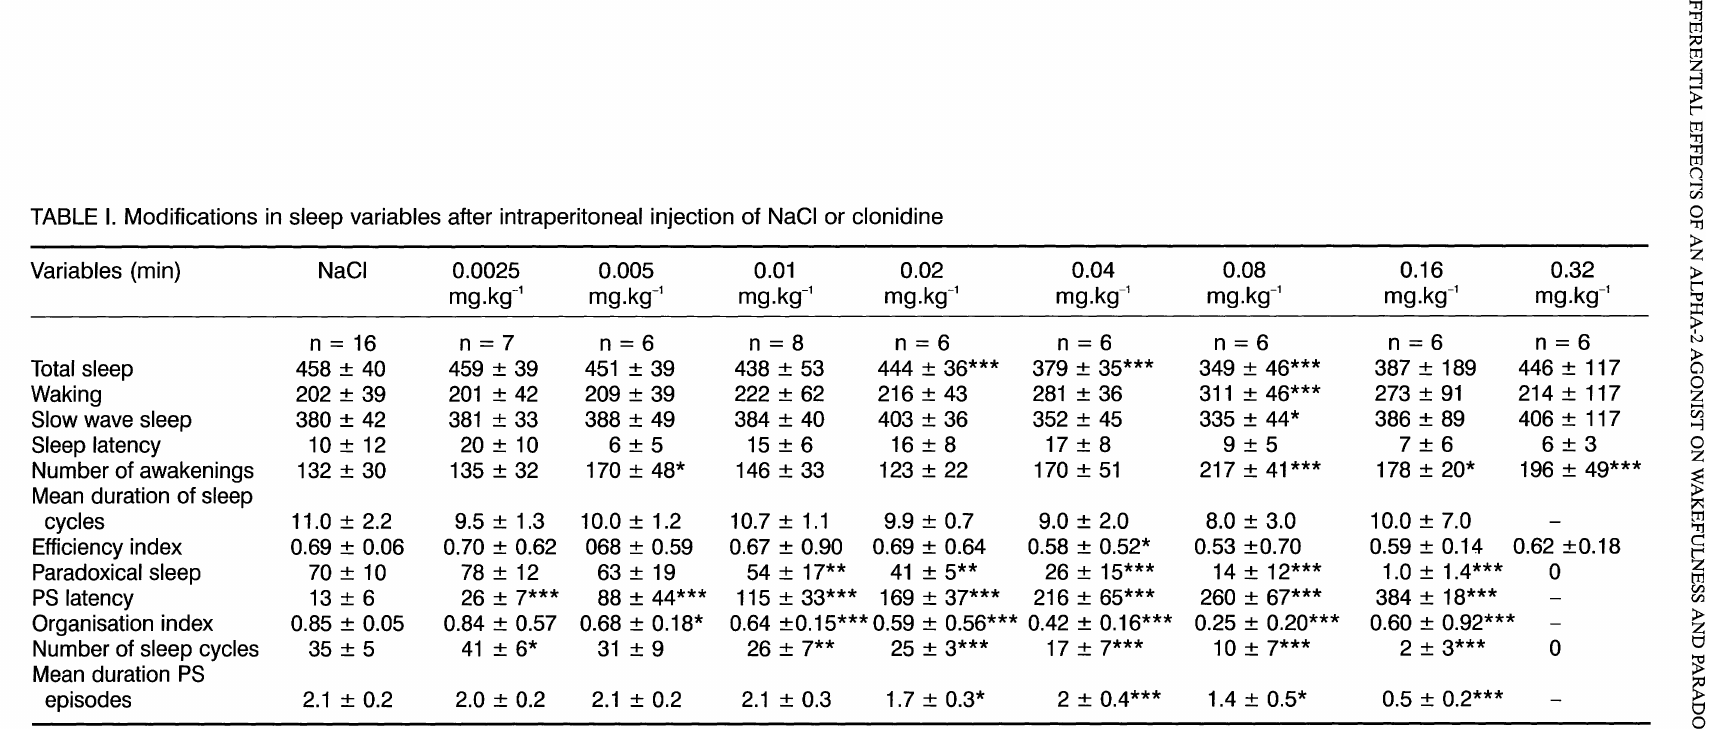
Values of the main parameters of vigilance states in the rat under the effect of various doses of clonidine. All durations are in minutes ± SD for controls; in the other columns only the mean is indicated. p < 0.05-; **: p < 0.01; ***: p < 0.005. The statistical estimations have been made with the Student's t-test after previous estimations of homogeneity of the variances. Every dose of GLN was compared with the controls. Because of the number of comparisons carried out, the level of significance is p <